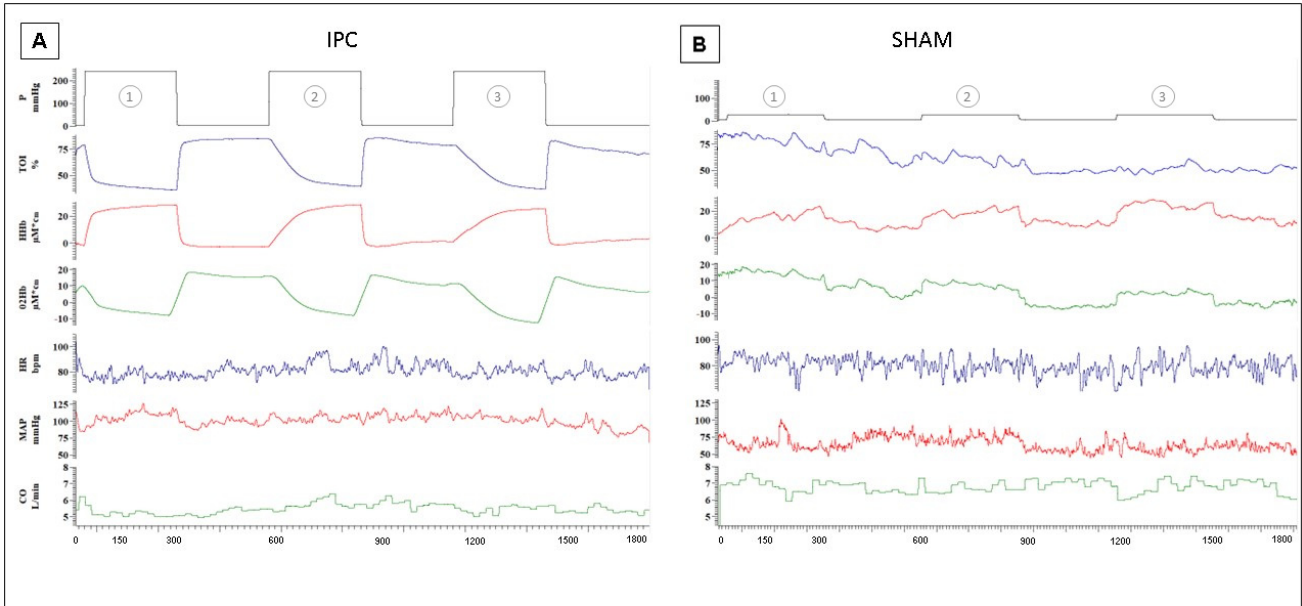
Figure 6. Hemodynamic responses to 1st (1), 2nd (2), and 3rd (3) compressive stimuli in IPC ( A ) and SHAM ( B ) in two representative subjects. From top to bottom: Cuff Pressure (P); tissue oxygenation index (TOI); changes in deoxy-hemoglobin (HHb = deoxHb + deoxyMb), oxy-hemoglobin concentration (O 2 Hb = oxyHb + oxyMb), heart rate (HR); arterial blood pressure (MAP) and cardiac output